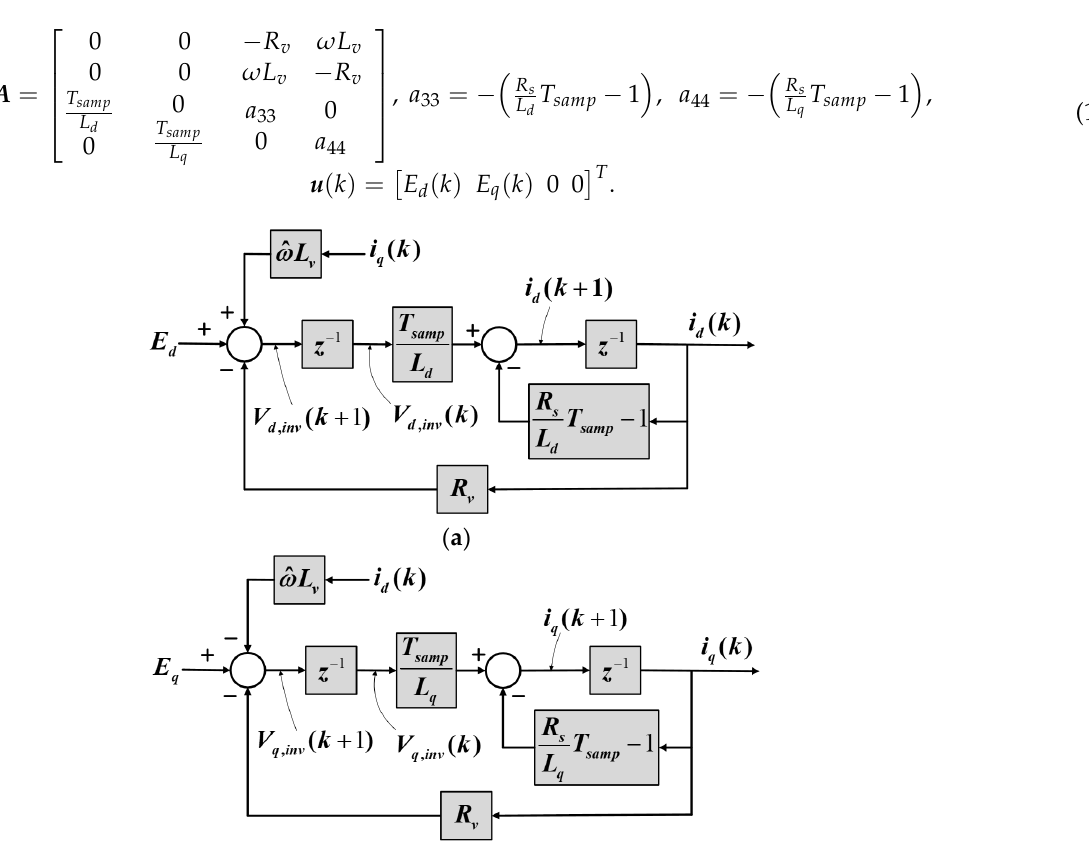
Figure 7. The d , q axis system block diagrams of the proposed flying start based on the discrete inverter model. ( a ) The d- axis model and ( b ) the q- axis model.